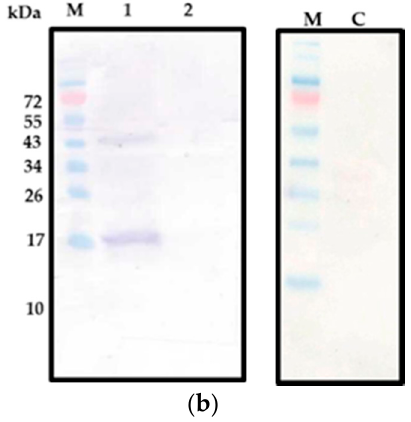
Figure 1. Expression of cecropinB2 in E. coli ER2566 and B. subtilis WB800. ( a ) Western blot of pET26b-INT-cecB2/ E. coli ER2566; where Lane M, molecular weight markers (kDa); Lane 1, supernatant; Lane C: control (supernatant of ET26b/ E. coli ER2566); The cell debris was centrifuged at 7000 g at 4 °C for 10 min to obtain the supernatant (Lane 1); ( b ) Western blot of PRPA-cecB2/ B. subtilis WB800; where Lane M, molecular weight markers (kDa); Lane 1, cell crude extract; Lane 2, 100 × concentrated extracellular fluid; Lane C: control (cell crude extract of PRPA-/ B. subtilis WB800). The culture broth was centrifuged at 6000 × g at 4 °C for 10 min to obtain the cell and extracellular fluid.